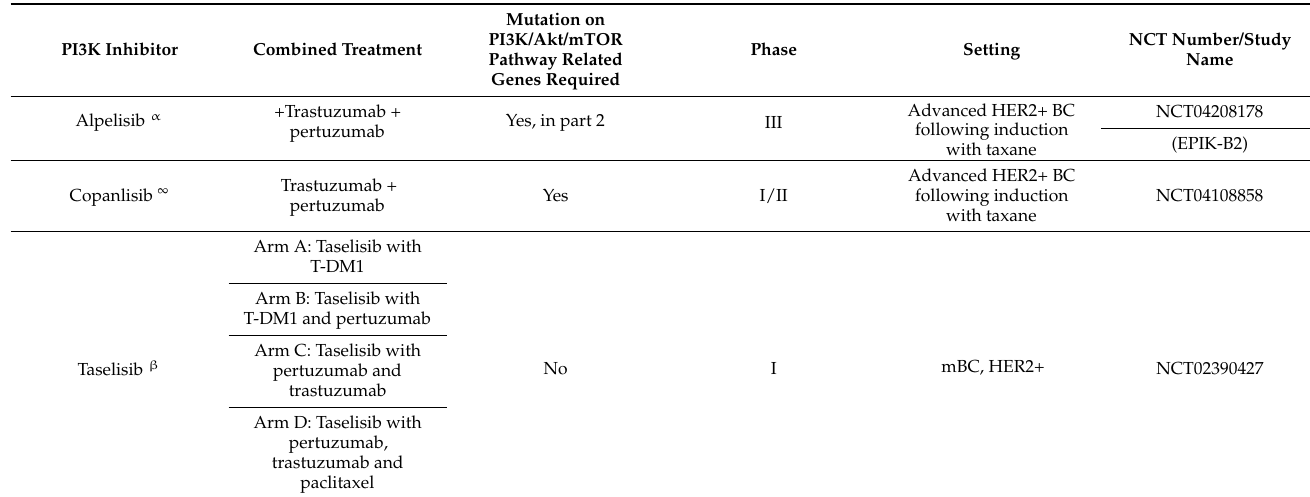
Table 1. Clinical trials of PI3K/AKT/mTOR inhibitors in HER2-positive and triple negative breast